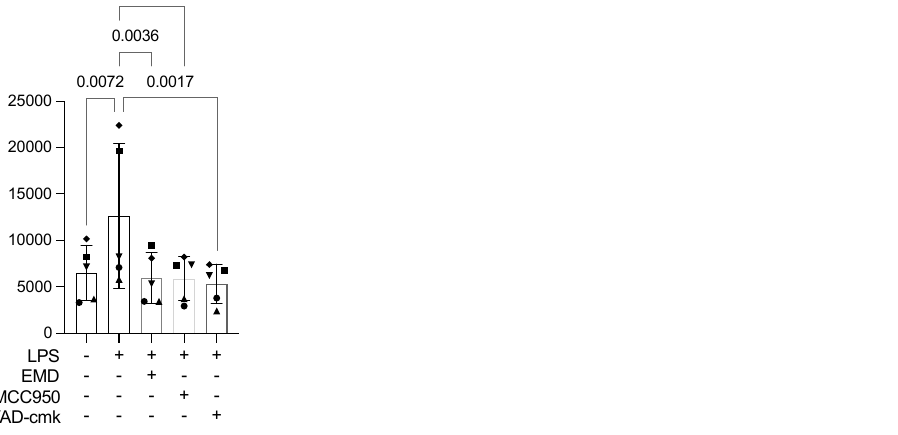
Figure 5. LPS stimulation caused an increase in the reactive oxygen species (ROS) release in RAW 264.7 macrophages. The application of EMD, MCC950, or Ac-YVAD-cmk in LPS-induced RAW 264.7 cells showed a significant reduction in ROS release. Different symbol shapes mean independent experiments. Repeated measures of one-way ANOVA followed by Dunnett’s multiple comparison tests, comparing every group to the LPS group, were applied.